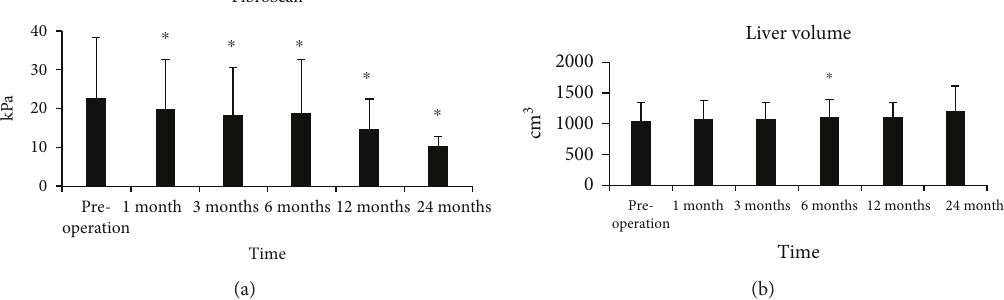
Figure 2: The change of patients ’ FibroScan (a) and liver volume (b). ∗ P < 0 05 compared to preoperation. The numbers of compared pairs of FibroScan at 1 month, 3 months, 6 months, 12 months, and 24 months were 45, 37, 30, 31, and 6, respectively. The numbers of compared pairs of liver volume at 1 month, 3 months, 6 months, 12 months, and 24 months were 37, 28, 28, 22, and 5, respectively. The sample sizes of FibroScan were 55, 48, 40, 34, 32, and 6 to preoperation, 1 month, 3 months, 6 months, 12 months, and 24 months, respectively. The sample sizes of liver volume were 50, 44, 36, 35, 30, and 6 to preoperation, 1 month, 3 months, 6 months, 12 months, and 24 months,